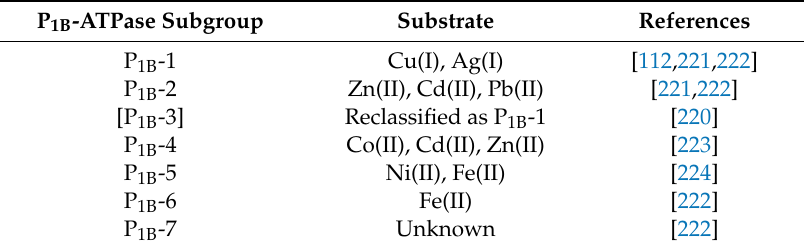
Table 4. Classification of P 1B